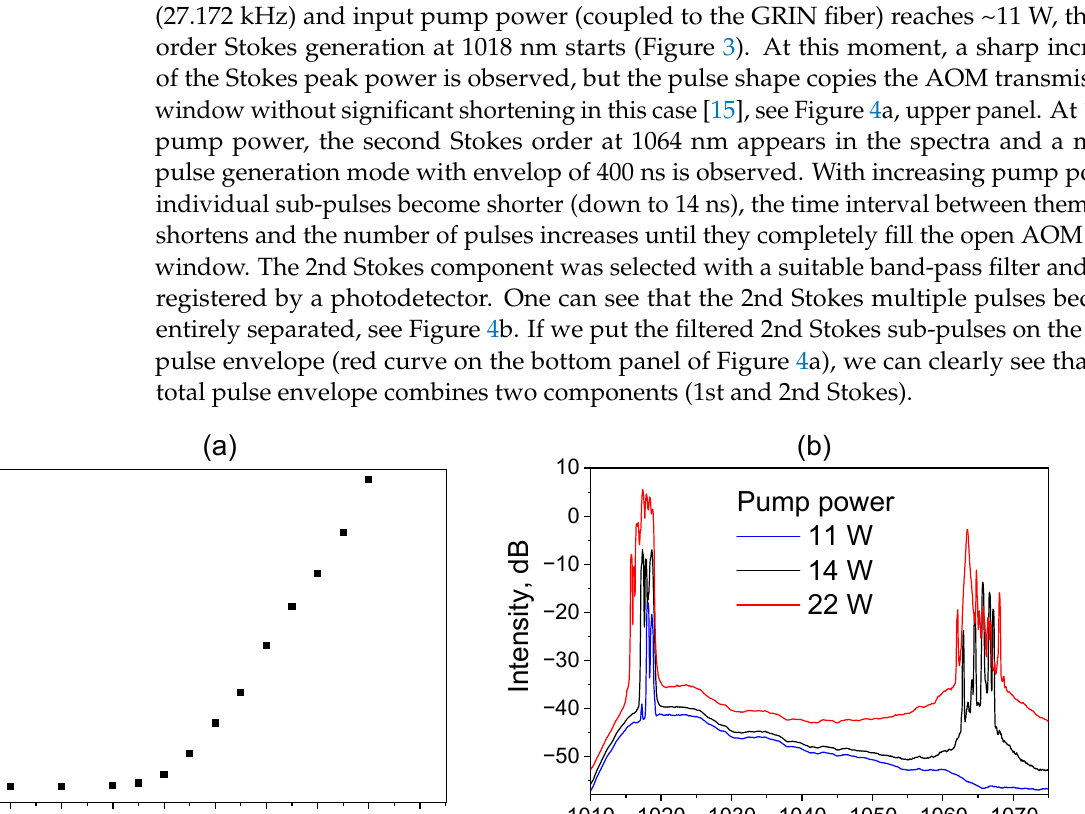
Figure 4. Output pulses (involving all Stokes orders) at different pump powers in 62.5- μ m GRIN fiber Raman laser with open-space AOM ( a ) and filtered 2nd Stokes pulses ( b ).